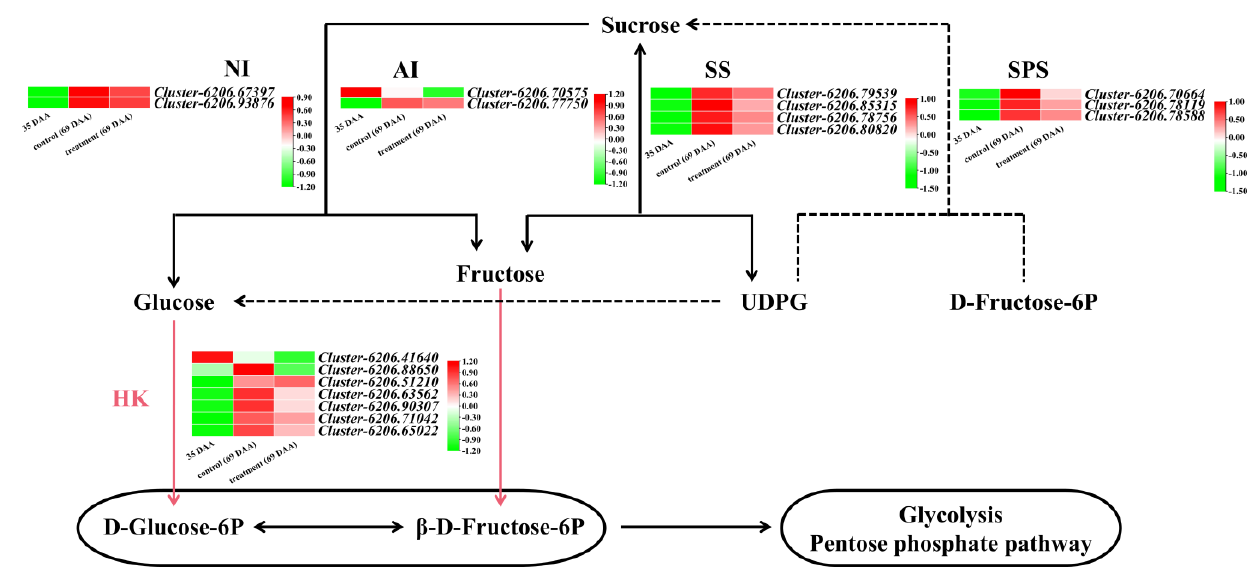
Figure 5. Map of the sugar metabolism pathway and heatmap of related differentially expressed genes in ‘Feizixiao’ litchi pulp between the treated and control groups in 2020.